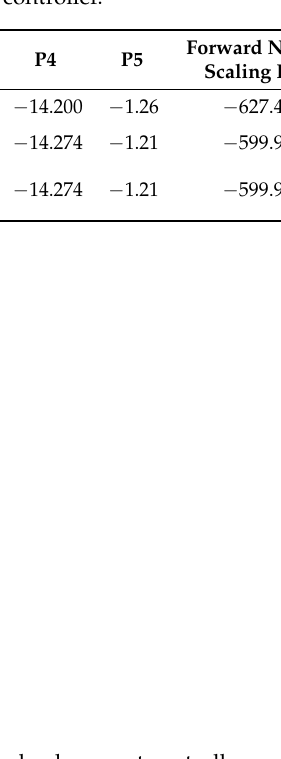
Figure 7. Pitch angle step response with and without faults—pole placement